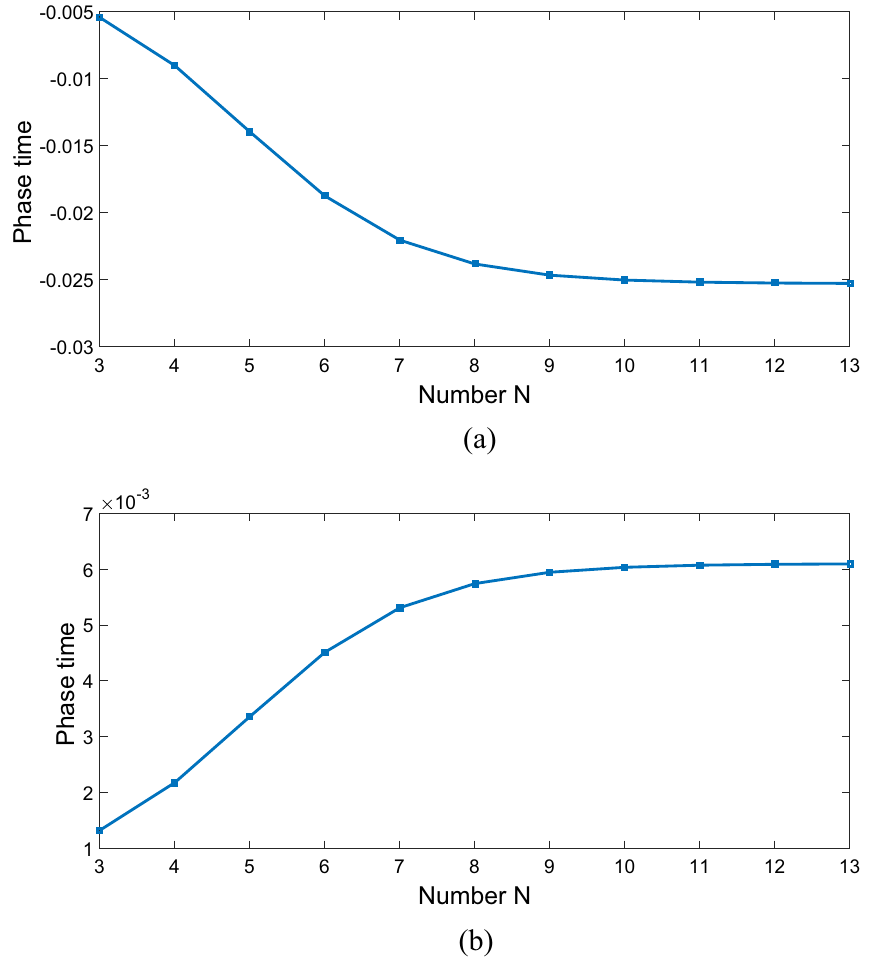
Figure 7. The Hartman effect in a 1DPC’s with structure ( AB ) 2 ADA ( BA ) N when only one control field (cid:31) c has an optical vortex with azimuthal phase (cid:31) = 0 ( a ), � = 2 π 3 ( b ). Other parameters are �ϕ = 0, � p = 0.2 γ , � d = 0.9 γ , ω c = 1 µ m, l = 2, r = 1 , and E c = γ